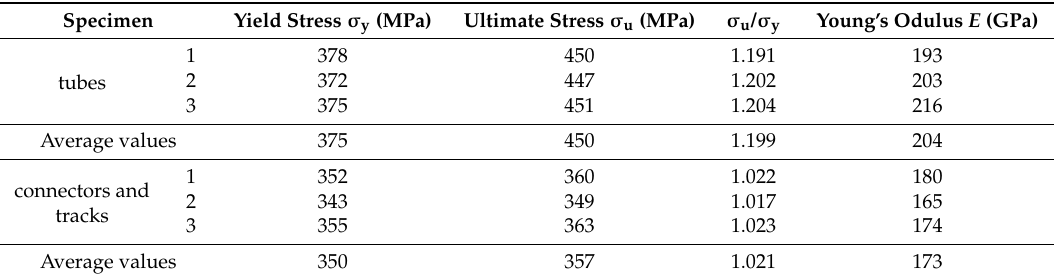
Table 2. Material properties.